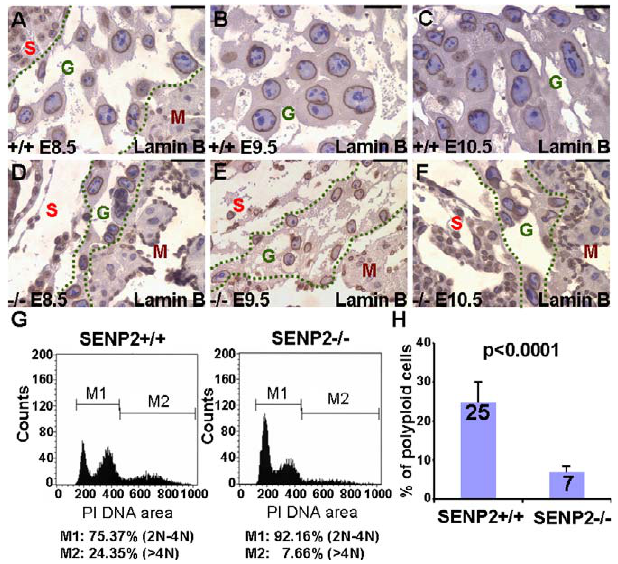
Figure 8. SENP2 Is Required for Trophoblast Maturation (A–F) Immunostaining of the E8.5 (A,D), E9.5 (B,E) and E10.5 (C,F) SENP2 þ / þ (A–C) and SENP2 –/– (D–F) placentas with lamin B, which marks nuclear envelopes, shows the size of nuclei. The TGC layers are defined by broken green lines. The stained (brown) sections were counterstained (blue) with hematoxylin. Note that the SENP2-null TGCs (D–F) contain smaller nuclei with less dotted staining (representing nucleoli and heterochromatin) than the controls (A–C). (G) Endoreduplication is impaired by the loss of SENP2. The SENP2 þ / þ and SENP2 –/– TS cells were induced for differentiation into TGCs in vitro. Flow cytometric analysis of the differentiated SENP2 þ / þ and SENP2 –/– cells, stained with PI, was used to measure their DNA contents (M1, two to four copies; M2, more than four copies). The diagram in (G) is a representative of five independent experiments; the average percen- tages of the SENP2 þ / þ and SENP2 –/– polyploid cells in all five cultures is presented in (H) ( p , 0.0001, n ¼ 5). G,TGC layer; M, maternal decidua; S, spongiotrophoblast layer. Scale